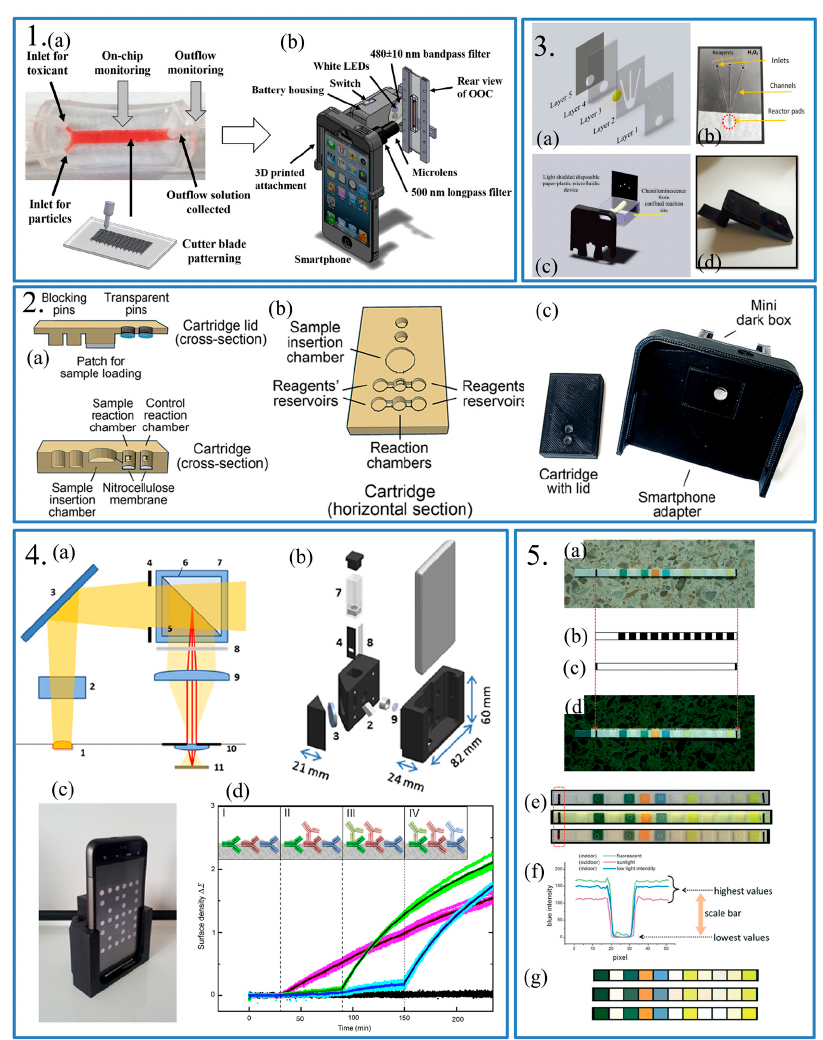
Figure 4. Panel 1: ( a ) Photograph of the microfluidic device and schematic of cutter blade patterning; ( b ) Schematic of the dual-mode monitoring of organ-on-a-chip with smartphone based fluorescence microscope. Reproduced from [34]. Panel 2: ( a ) The cross-section schematic of the cartridge lid and cartridge; ( b ) The horizontal section schematic of the cartridge; ( c ) Photograph of the cartridge-lid assembly and of the min dark box and smartphone adapter. Reproduced from [36]. Panel 3: ( a ) Exploded view and ( b ) Photograph of the custom-designed paper-plastic disposable microfluidic device; ( c ) Schematic of the smartphone accessory for video capture of chemiluminescence reaction. ( d ) Photograph of the smartphone-based confined chemiluminescence detection device. Reproduced from [37]. Panel 4: ( a ) Schematic and ( b ) Exploded view of the optical elements contained in the plastic cradle; ( c ) Photograph of the smartphone-based label-free immunoassay; ( d ) The surface density measured by the smartphone. The times of the target additions were indicated as vertical dashed lines. Inset: the binding of the target antibodies in solution to the immobilized IgG is schematically represented before and after the additions (I-IV). Reproduced from [38]. Panel 5: ( a ) An optical image of a urine strip consisting of 12 paper-based sensors in array; ( b , c ) The mono-color template using to estimate the position of each sensor array; ( d ) Image resulting from the automatic recognition; ( e ) Images of a urine strip under different light condition, from up to down: indoor fluorescent light, outdoor sunlight and indoor low light intensity conditions; ( f ) The blue color profiles of the black and white background were measured in the dotted red rectangle in ( a , g ). The corrected colors were obtained from the colors of ( a ) by the correction protocol. Reproduced from